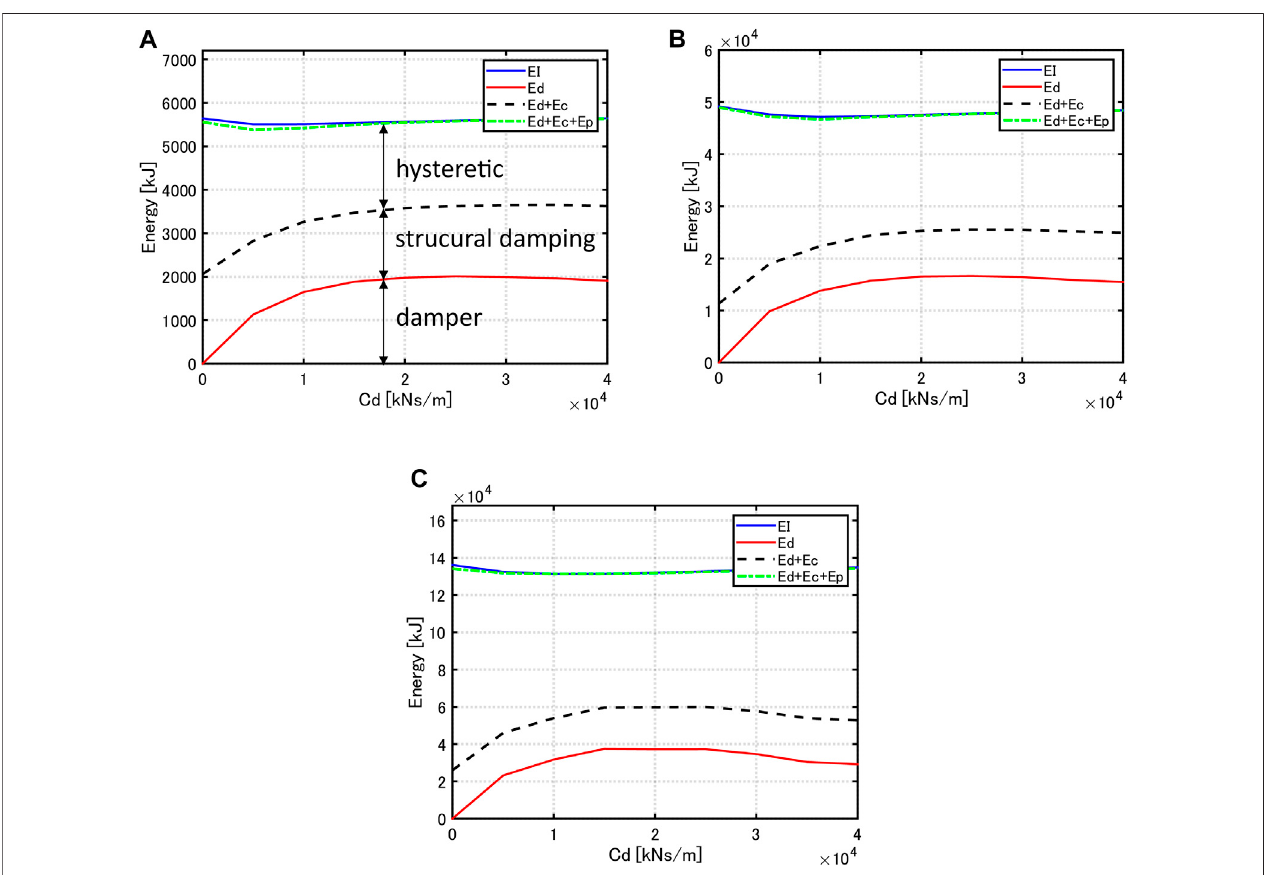
FIGURE 11 | Energy response with respect to damper quantity under critical double impulse, (A) V DI (cid:1) 0 . 20 [ m / s ] , (B) V DI (cid:1) 0 . 40 [ m / s ] , (C) V DI (cid:1) 0 . 60 [ m / s ] .